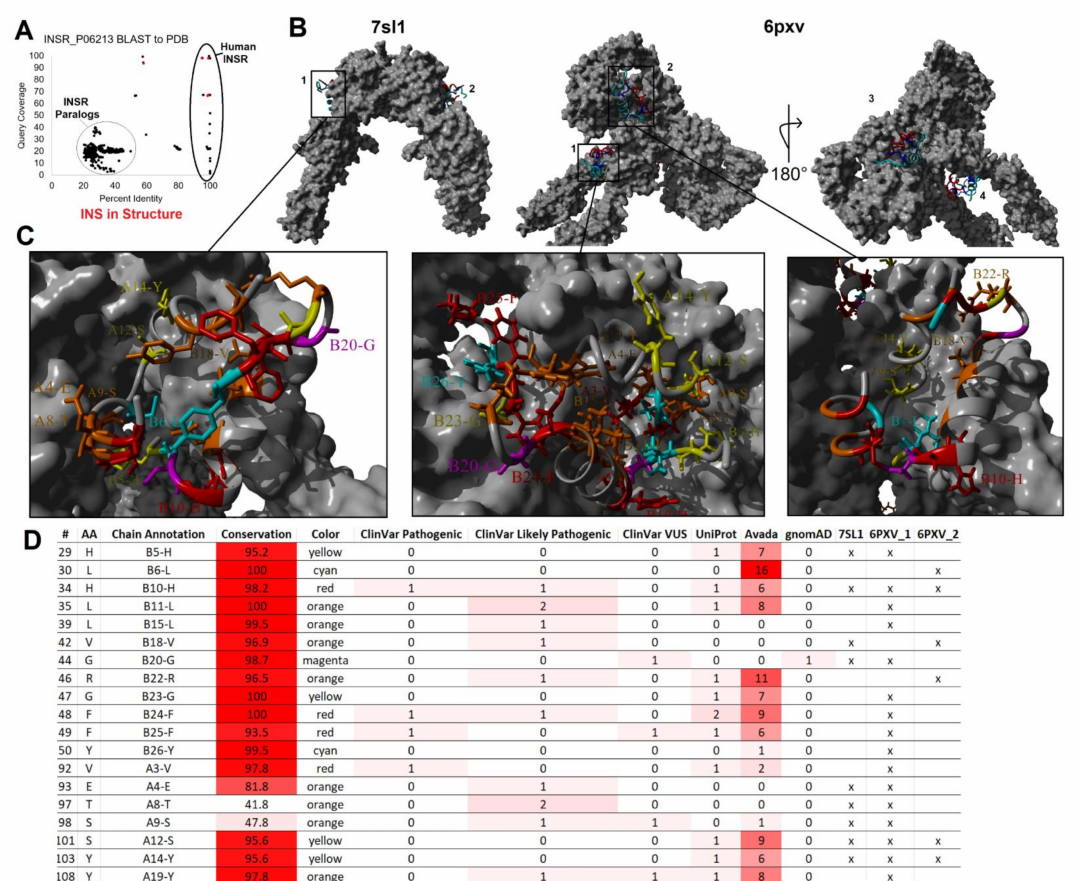
Figure 8. Mapping variants to insulin and insulin receptor interaction. ( A ) BLAST analysis of sequences within the PDB similar to human insulin receptor (UniProt P06213) with the percent identity of the sequence from the structure shown on the x-axis and the coverage of sequence on the y-axis. Spots in red are present in Figure 6B, meaning they represent insulin and insulin receptor interactions. ( B ) The model of the full insulin receptor (gray) from PBD files 7sl1 and 6pxv. Insulin is colored with A-chain in red and B-chain in cyan with two insulin bound for 7sl1 and four for 6pxv. ( C ) Zoomed-in view of insulin docking with the receptor as called out in Panel B. Coloring of insulin is based on Figure 6D. ( D ) Table of insulin missense variants that form contacts from one of the three binding states of Panel C. The last three columns label the structures that contacts are found for insulin receptor with an